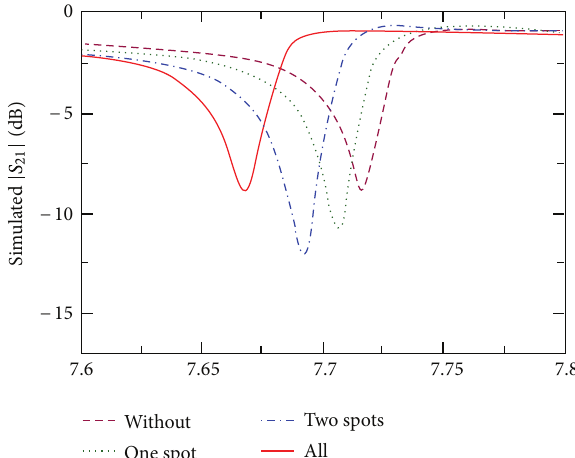
Figure 16: Measured transmission response of the aDSR for four degrees of coverage